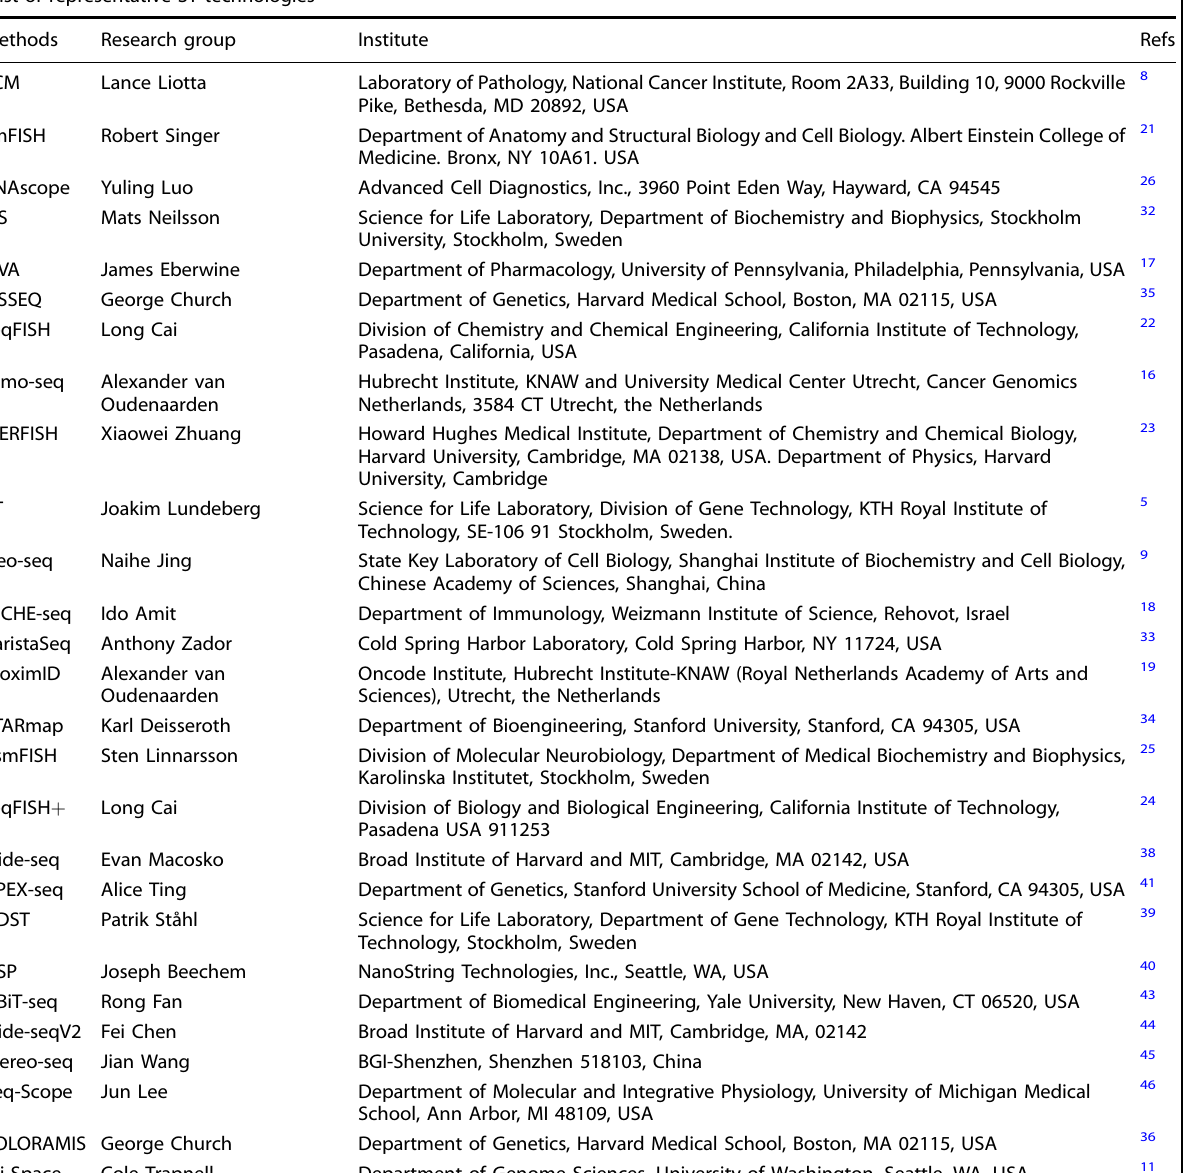
distributing them on a glass surface. 38 Slide-seq measures genome-wide expression at high spatial resolution and improves the detection of 3 ’ transcriptome gene expression in fresh-frozen tissues. As compared with other in situ capturing methods, tissue images obtained using Slide-seq originate from the contiguous tissue section, rather than the tissue section where RNA data is generated. HDST deposits barcodes into fi ner 2 µm wells with randomly ordered beads and decode positions by several hybridization processes (Fig. 2g). 39 The signals captured from HDST are highly speci fi c and conformant with those from bulk RNA-seq. Digital spatial pro fi ling (DSP) analyzes highly multiplex spatial RNAs and proteins. 40 Photocleavable oligonucleotide tags are applied to quantify the abundance of RNAs or proteins in DSP, with single- cell sensitivity in a customizable region consisting of about 5000 cells. Released indexing oligonucleotides tags are counted by the nCounter system or next-generation sequencing.